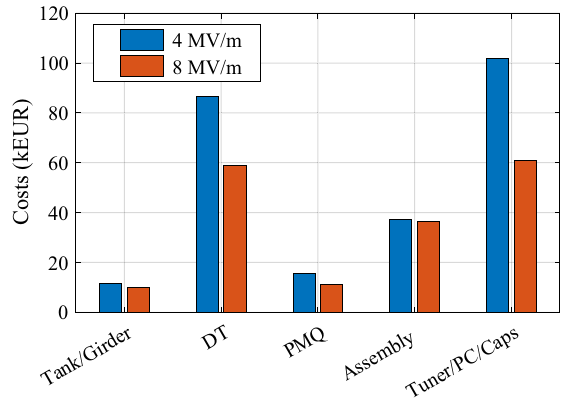
FIG. 18. A comparison of construction costs of different parts of a QA-DTL at the two values of an average axial electric field of 4 MV = m (blue) and 8 MV = m (red).